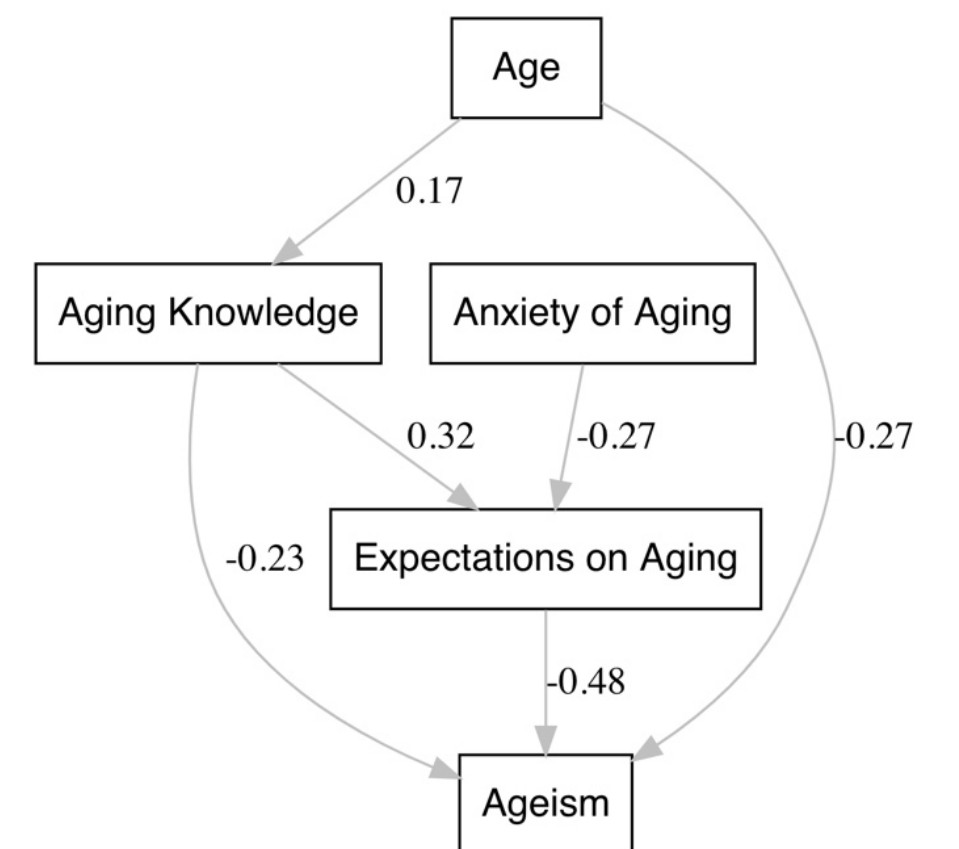
Figure 2. Path plot detailing relevant paths labeled with the standardized path coefficients from the final path analysis model (Model 5). All relationships depicted were significant at the α = 0.05 level.